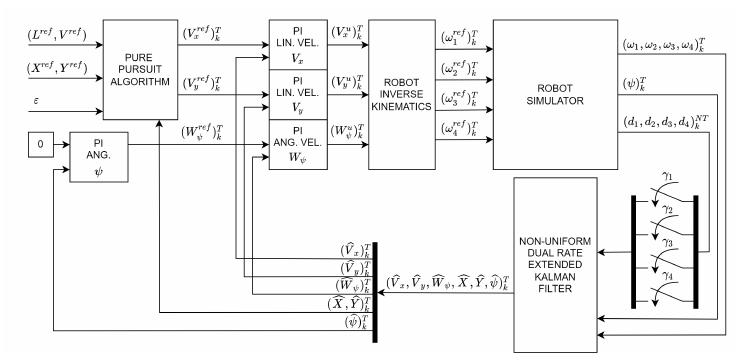
Figure 1. Control structure with NUDREKF estimator for the